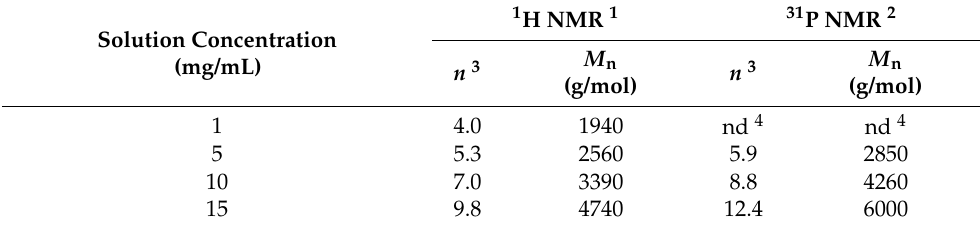
Table 2. The degree of polymerization ( n ) and number average molecular weight ( M n ) of the oligomeric species existing in the ZnDBP solutions in CDCl 3 calculated based on 1 H and 31 P NMR